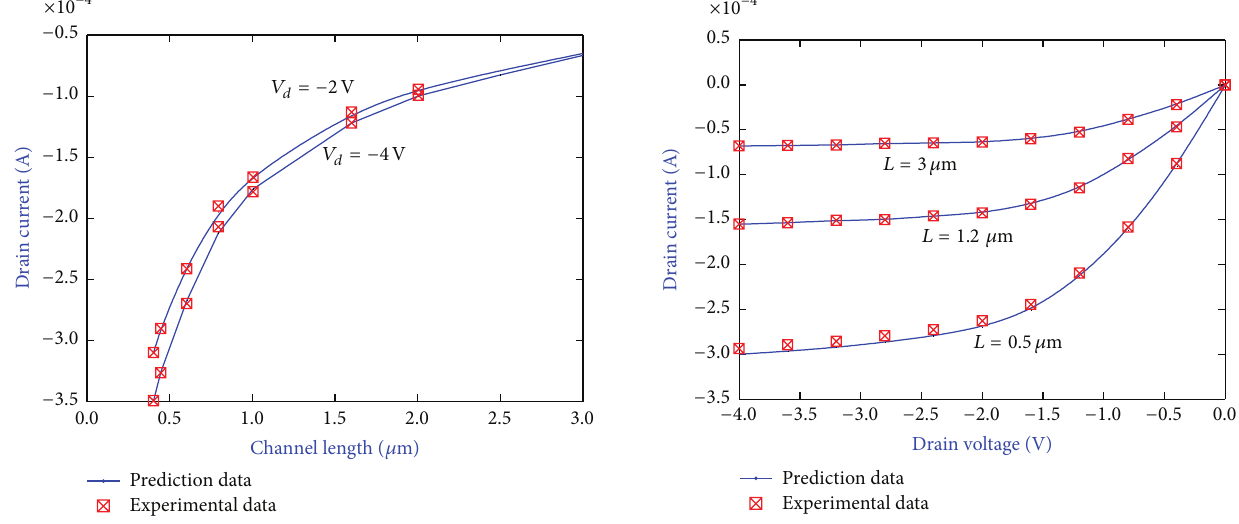
Figure 5: Comparison of 𝐼 𝑑 measured results and training predic- tion data of the group 1A samples (as 𝑉 𝑑 = −2 , − 4V; 𝑉 𝑔 = −3 V).